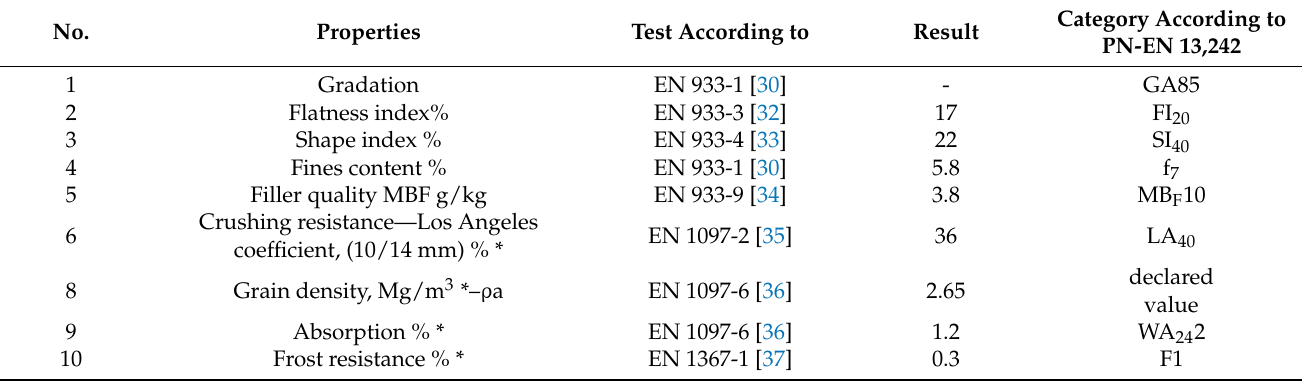
Table 4. The results of the determination of the geometrical, physical properties of recycled aggregate with a continuous gradation of 0/31.5